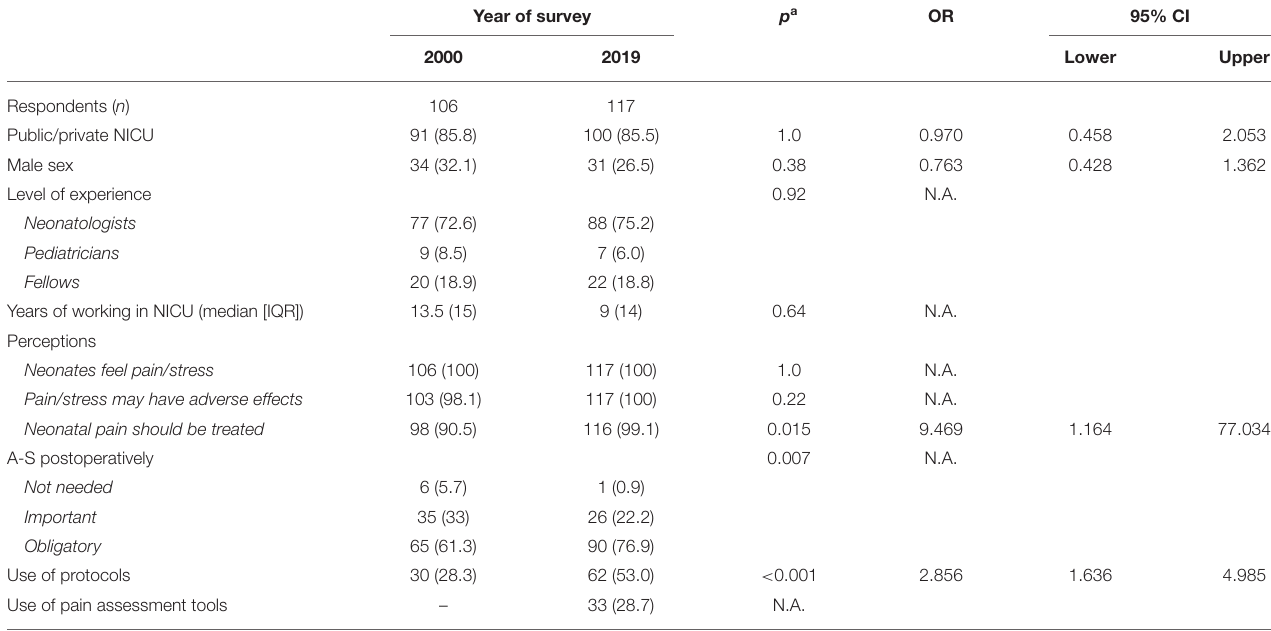
TABLE 1 | Demographic data and perceptions of the respondents.